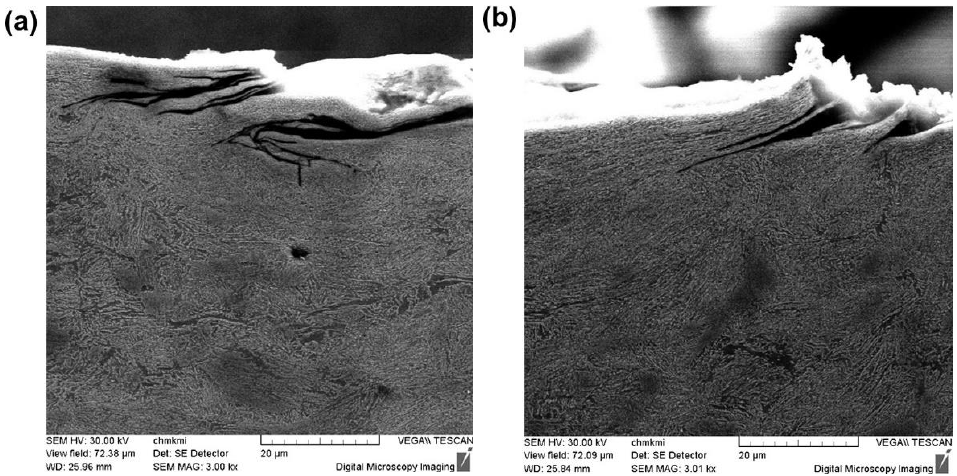
Figure 9. Damages in the surface layers of severe shot peening-treated 50CrMo4 steel specimens: ( a ) material peeling off from the surface; ( b ) a sharp notch under the peeled off material layer Reprinted with permission from Ref. [12]. Copyright 2014 Elsevier.